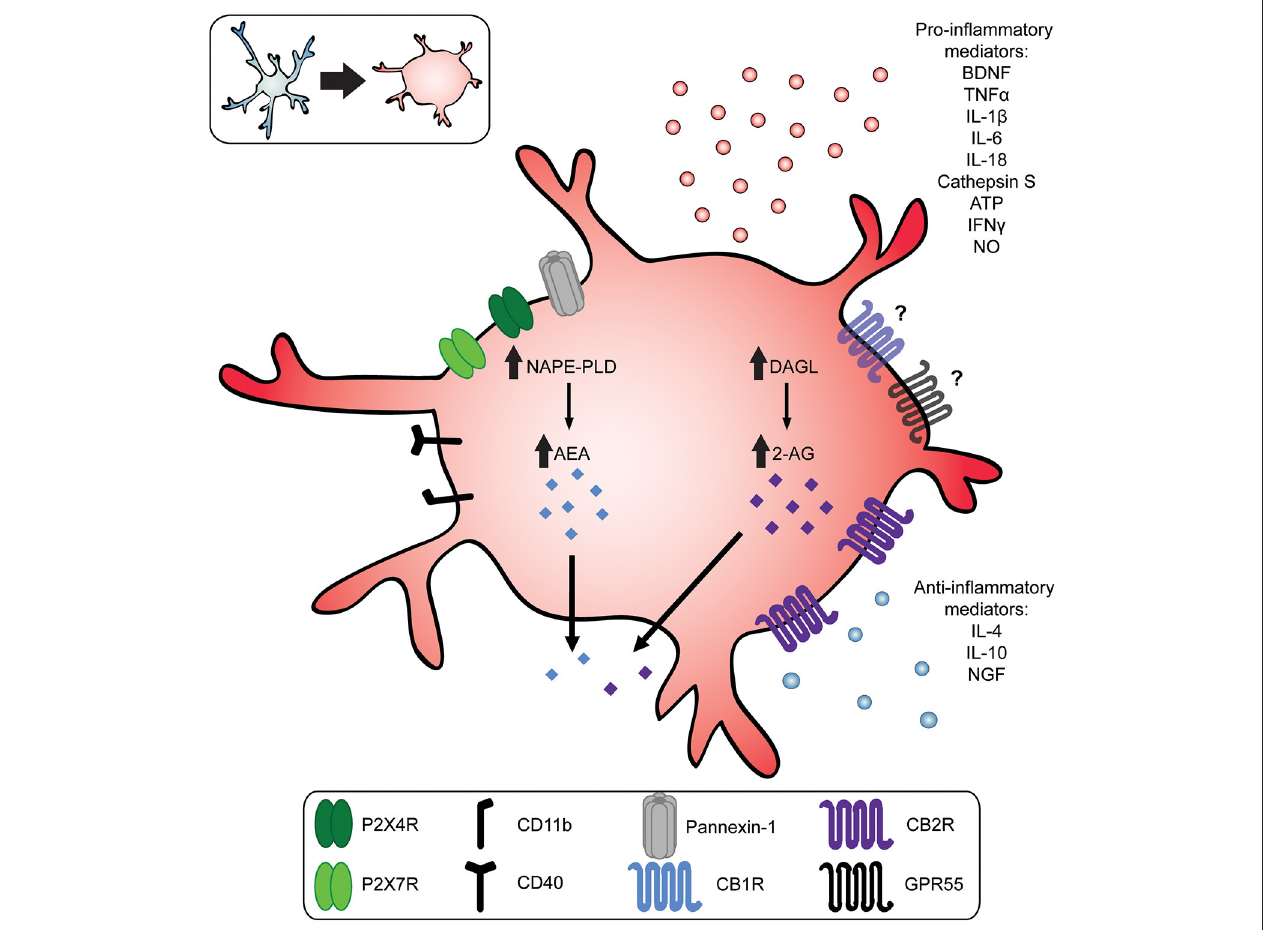
FIGURE 1 | Reactive microglia increase production of endocannabinoids and pro-inflammatory mediators. In response to injury, infection, or pathology of the nervous system, microglia transition toward a more reactive phenotype. This transition is characterized by a morphological change from a small soma with long, ramified processes (top left, blue) to a more amoeboid shape (top left and center, red). Upon activation, microglia release pro-inflammatory mediators, such as brain-derived neurotrophic factor (BDNF); adenosine triphosphate (ATP); nitric oxide (NO), interleukin 1 β (IL-1 β ), IL-6, IL-18, cathepsin S, interferon γ (IFN γ ), and tumor necrosis factor α (TNF- α ). Reactive microglia also increase production of the endocannabinoids anandamide (AEA) and 2-Arachidonoylglycerol (2-AG) mediated by N-acyl-phosphatidylethanolamine-phospholipase (NAPE-PLD) and diacylglycerol lipase (DAGL), respectively. Endocannabinoids and exogenous cannabinoids act on microglia CB2Rs, which are upregulated in chronic pain states, or they may act on CB1Rs or GPR55. This in turn upregulates the release of anti-inflammatory cytokines like interleukin 4 (IL-4); IL-10; and nerve growth factor